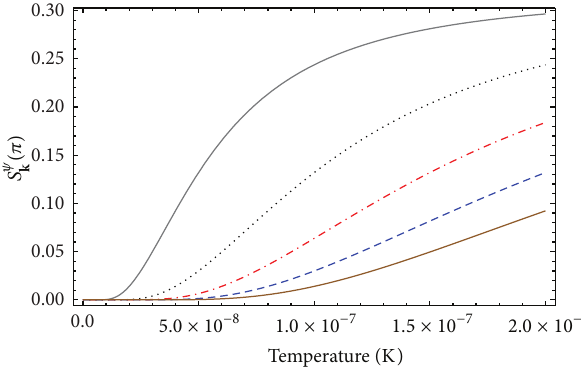
𝜓 k as a function of temperature